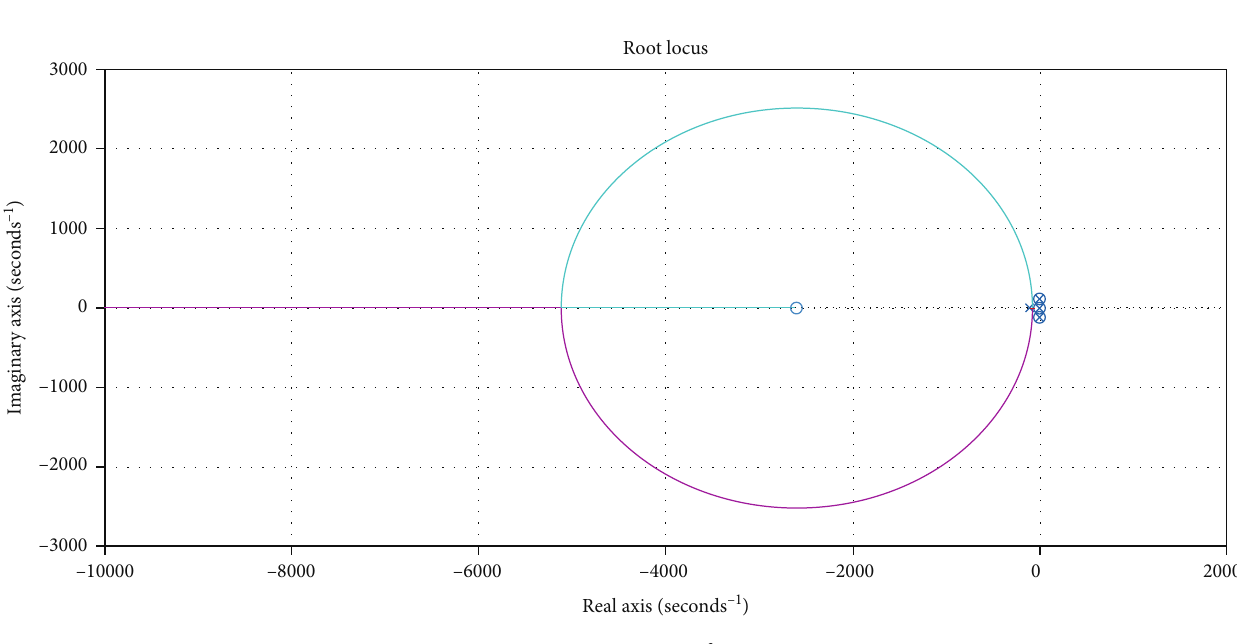
Figure 10: Bode plot of sys1 .